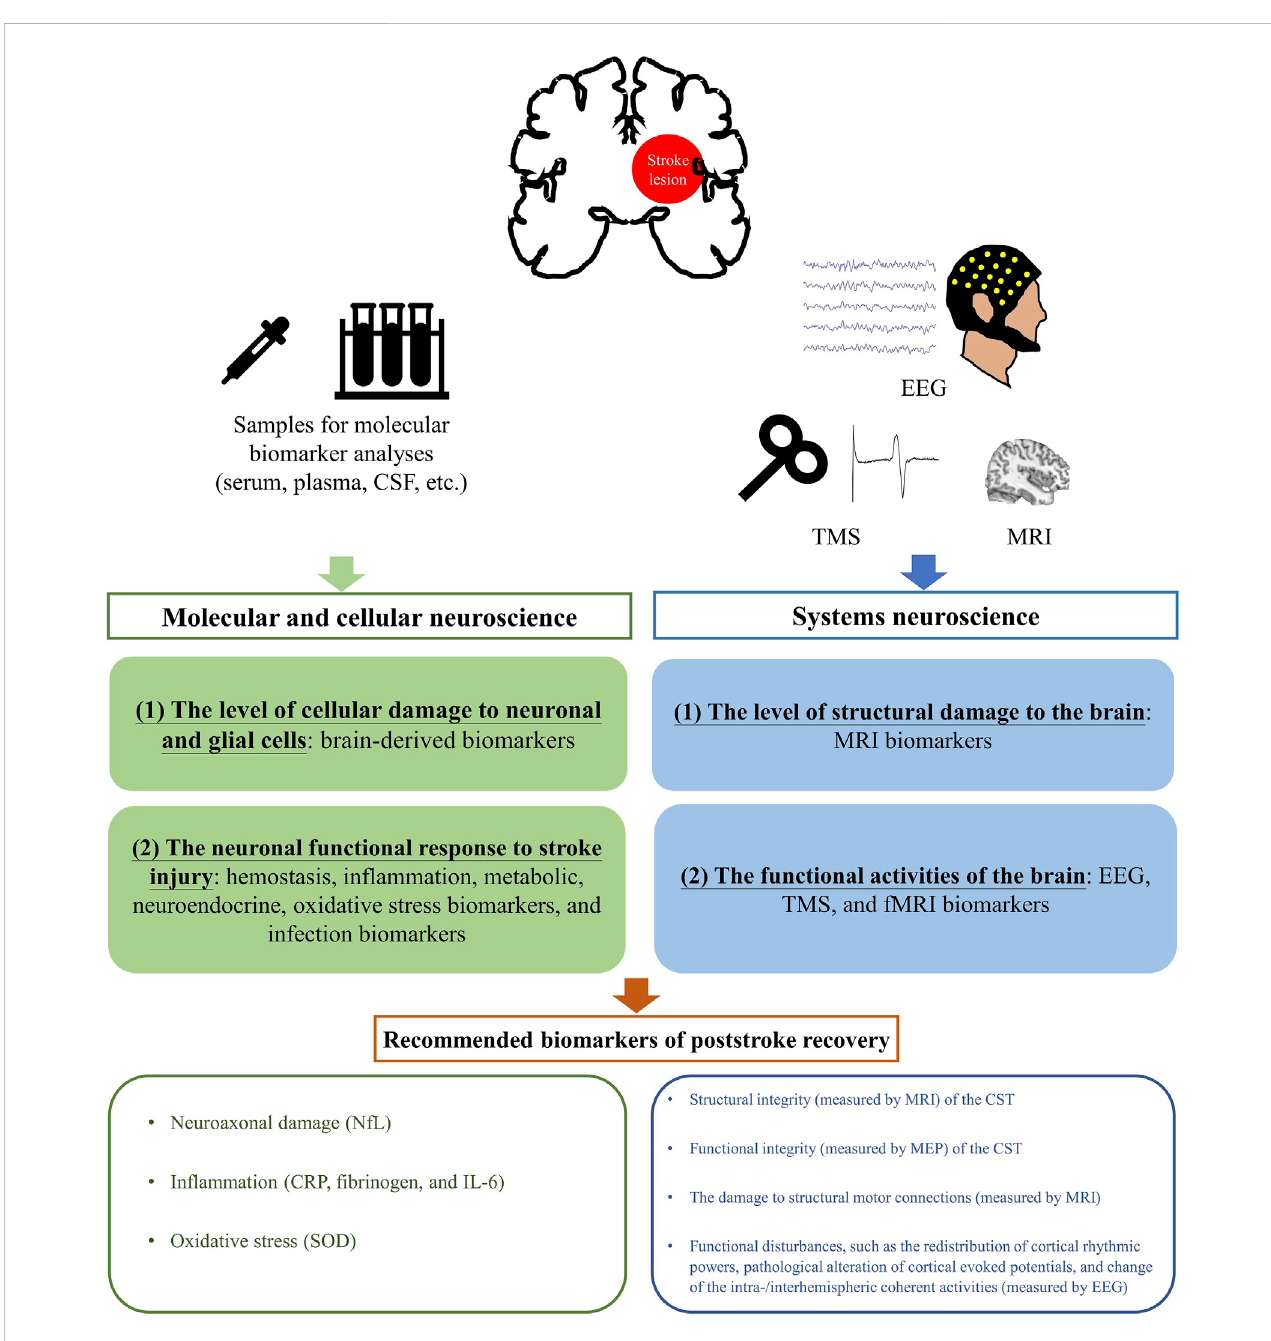
FIGURE 1 A schematic diagram of an integrative framework on the recommended biomarkers of poststroke recovery based on the review. Abbreviations: CRP, C-reactive protein; CSF, Corticospinal fl uid; EEG, Electroencephalography; fMRI, Functional magnetic resonance imaging; IL-6, Interleukin-6; MEP, Motor evoked potential; MRI, Magnetic Resonance Imaging; NfL, Neuro fi lament light chain; SOD, Superoxide dismutase; TMS, Transcranial magnetic stimulation.